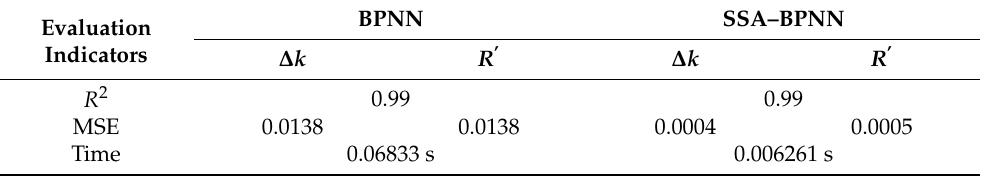
Table 7. Comparison of prediction effect between BPNN and SSA – BPNN.